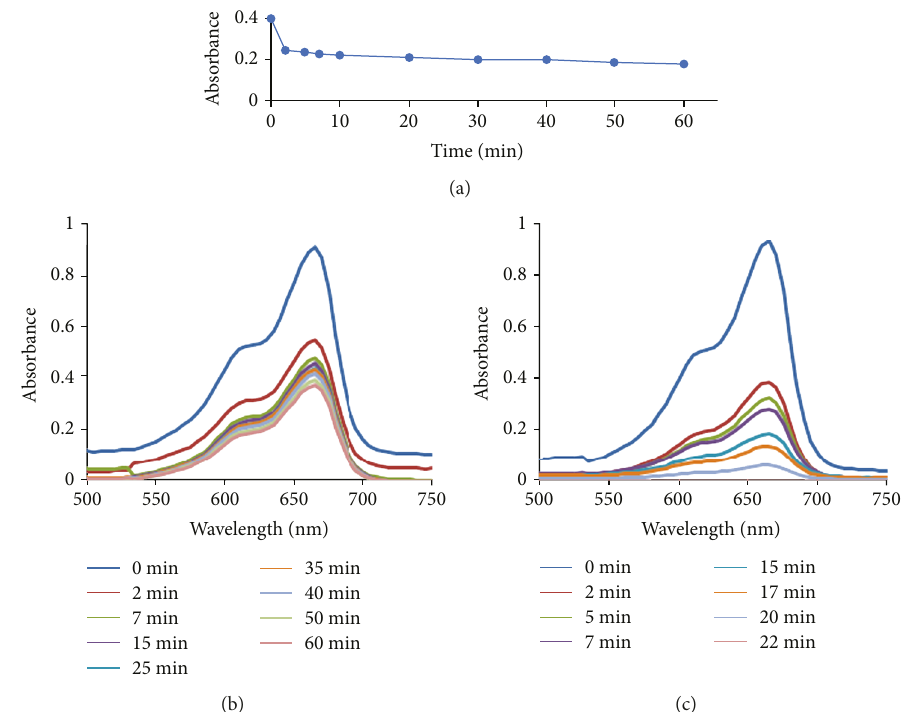
Figure 5: UV-Vis absorption spectra recorded for the progress in reduction of MB dye: (a) 2.5mL of MB ( 2 5 × 10 − 5 M ) solution and 2.5mL of fresh Citrus limon extract, (b) 2.5mL of MB ( 2 5 × 10 − 5 M ) solution and 2.5mL of fresh Citrus limon extract with 0.25g of CPUF, and (c) 2.5mL of MB ( 2 5 × 10 − 5 M ) solution, Citrus limon extract, and ascorbic acid (50 :50) with 0.25g of